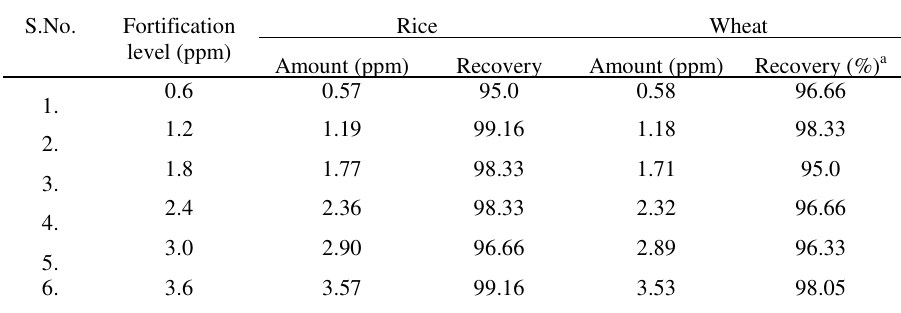
Table 3: Recoveries of dimethoate residues from grain samples using azure-B as reagent